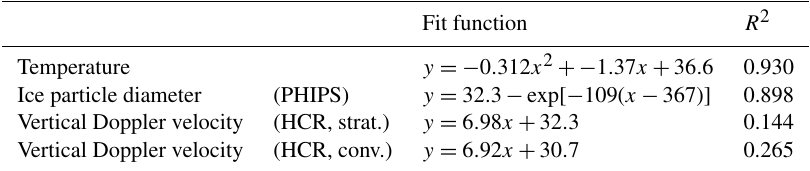
Fig. 12: An unrimed ice particle (a) accretes a supercooled droplet and forms the initial primary “normal” riming